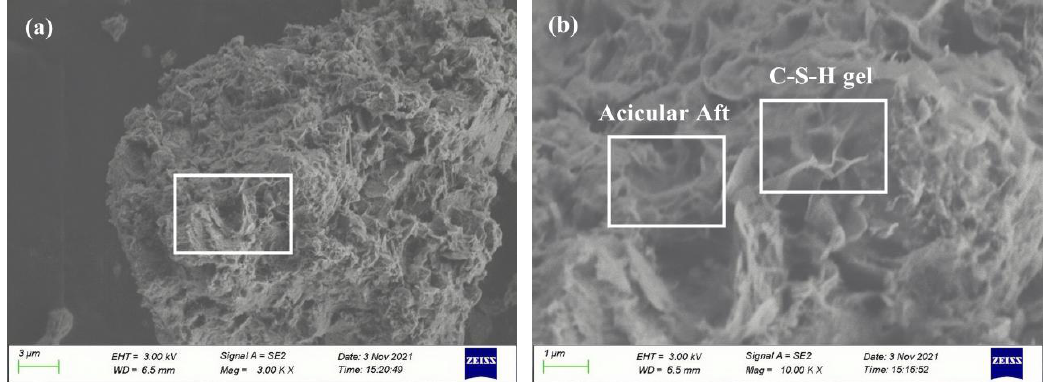
Figure 9. Composite-cemented soil cured for 7 d. ( a ) (3.00 kx magnification) and ( b ) (10.00 kx